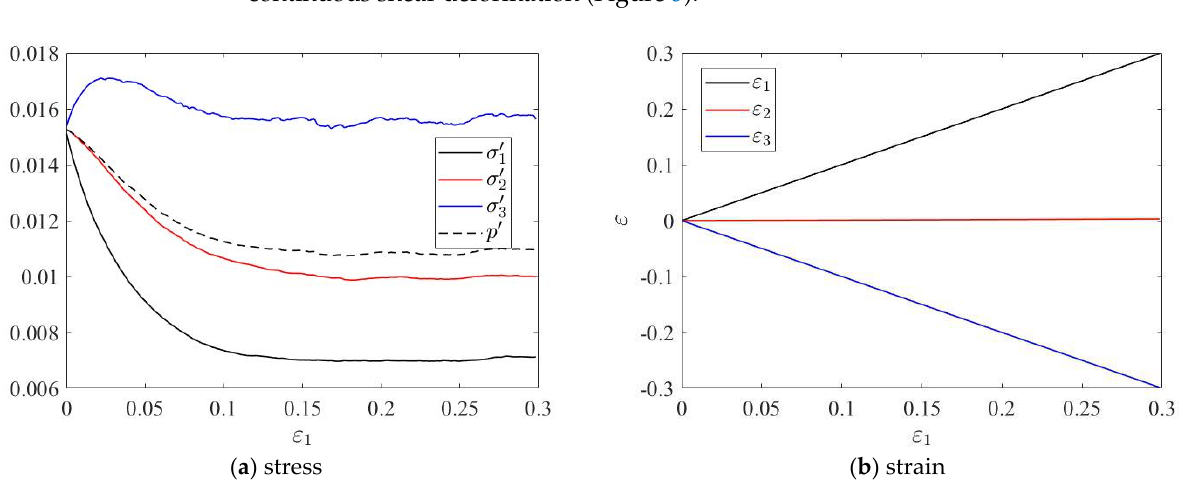
Figure 4. Specimens in this study.